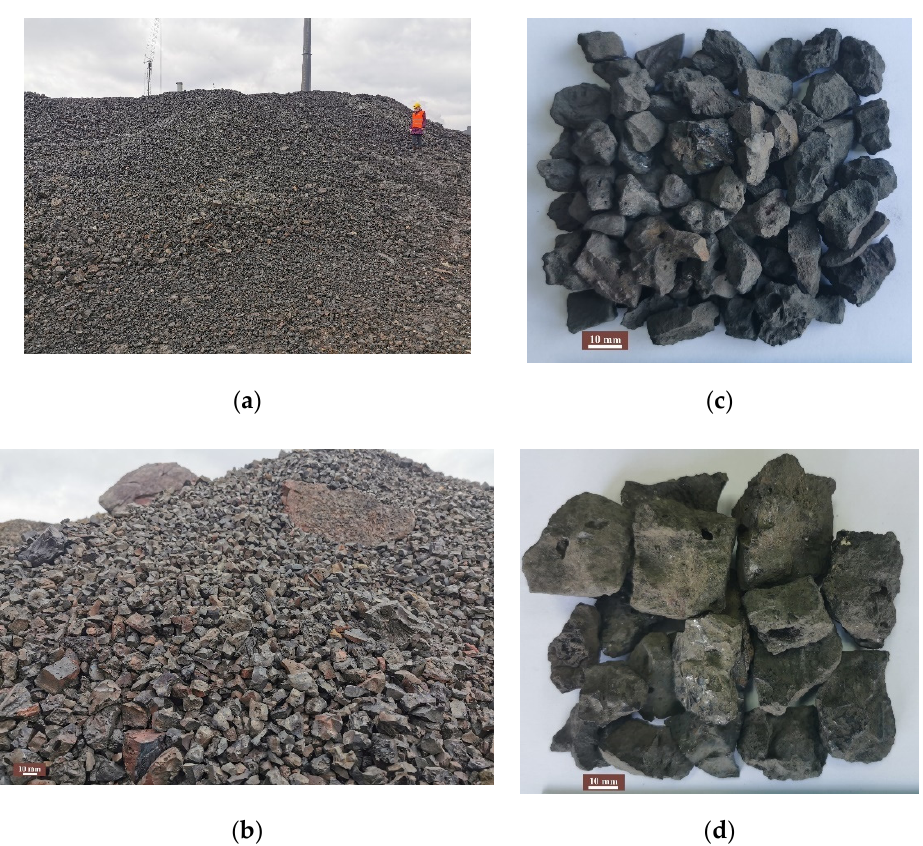
Figure 1. ( a ) Landfill of copper slag aggregates in the vicinity of the processing facilities of the Mining and Smelting Basin Bor; ( b ) macroscopic view of copper slag aggregate at the landfill; ( c ) macroscopic view of copper slag aggregate (8/16 mm); ( d ) macroscopic view of copper slag aggregate (16/31.5 mm).